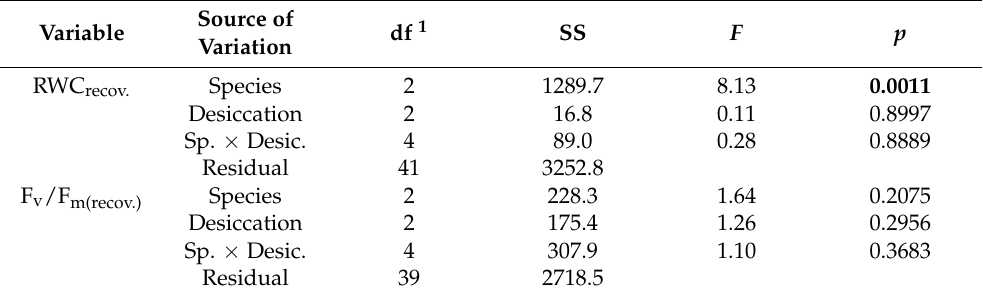
Table 2. ANOVAs for testing differences in relative water content (RWC) and maximum photochemical efficiency of PSII (F v /F m ) among the three Oesporangium species after three desiccation levels (80%, 50%, and 10% relative humidities) followed by rehydration (recovery). F v /F m(recov.) is the ratio (F v /F m after recovery): (initial F v /F m ). Significant differences ( p < 0.05) are indicated in bold. n = 17 individuals per species. Source of Variable Variation RWC recov.